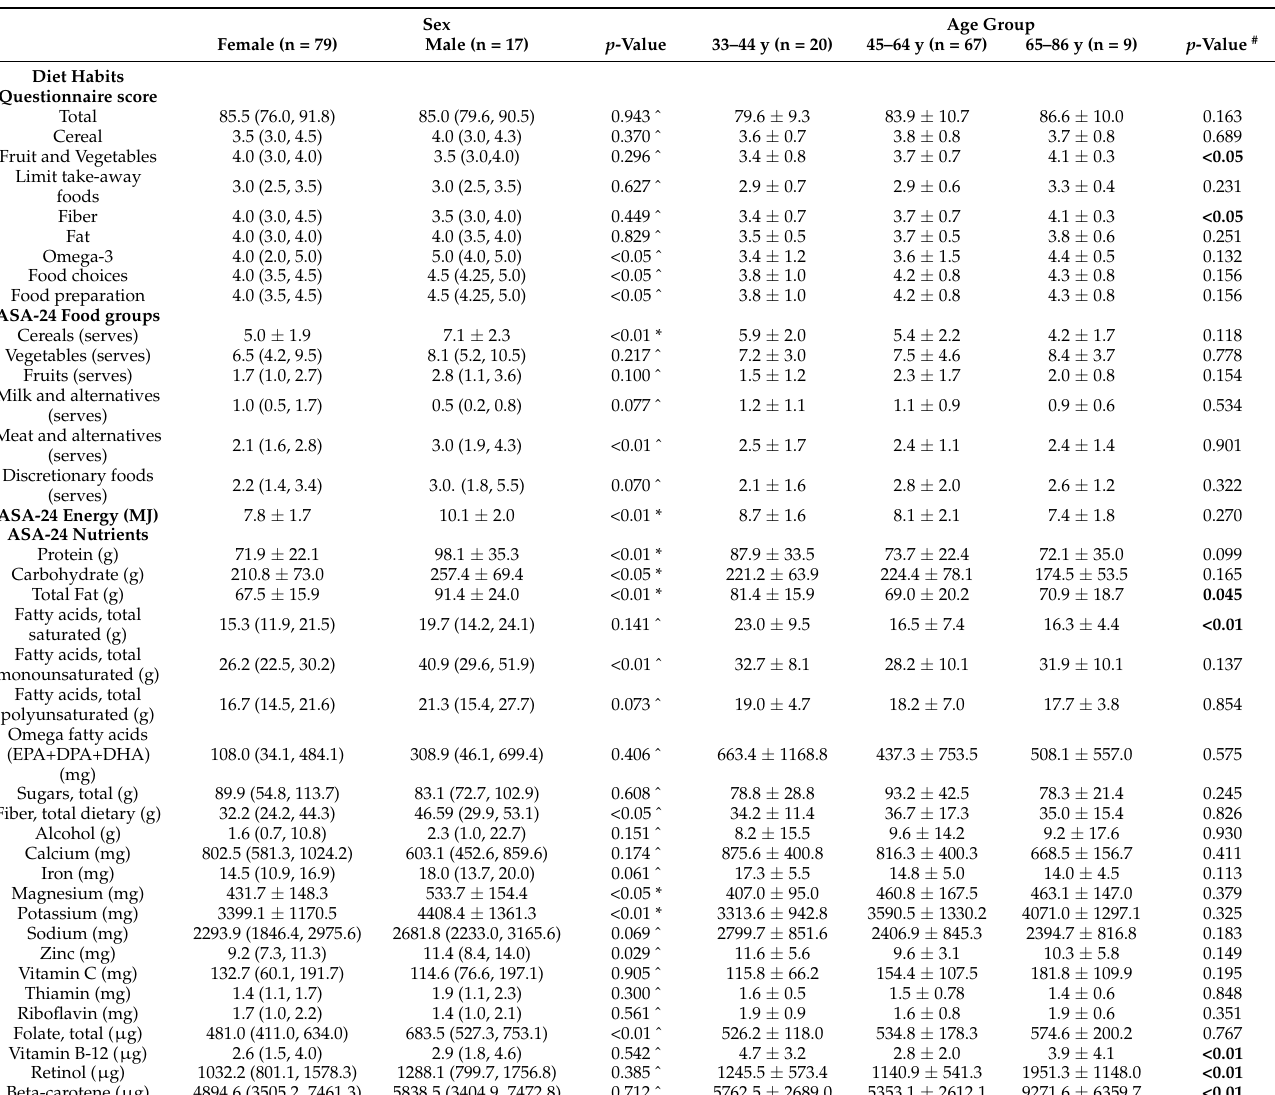
Table 4. Diet Habit Questionnaire scores and ASA-24 intake of food groups and nutrients, by sex